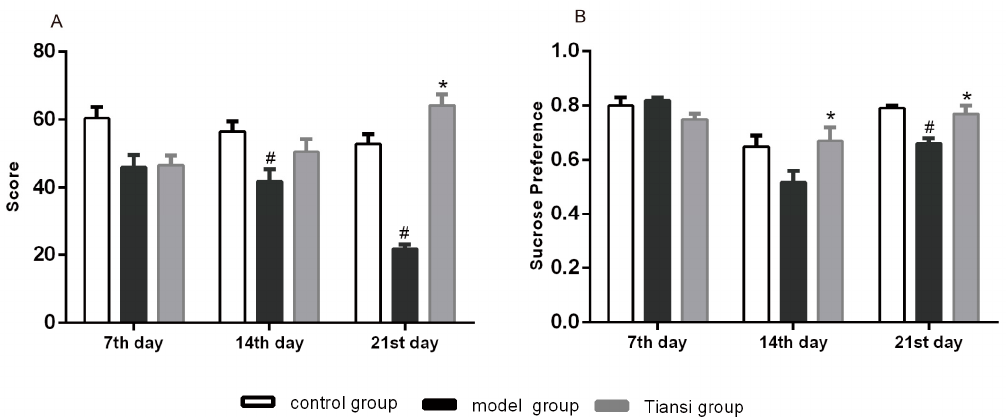
Figure 1. Effects of Tiansi Liquid treatment on the behavior of rats. Effects of Tiansi Liquid treatment on performance in the open field test ( A ) and sucrose preference test ( B ). Ten rats in each group. Statistical analyses were performed using one-way ANOVA and Tukey—Kramer post hoc comparisons. # p < 0.05, vs. control group; * p < 0.05, vs. model group.